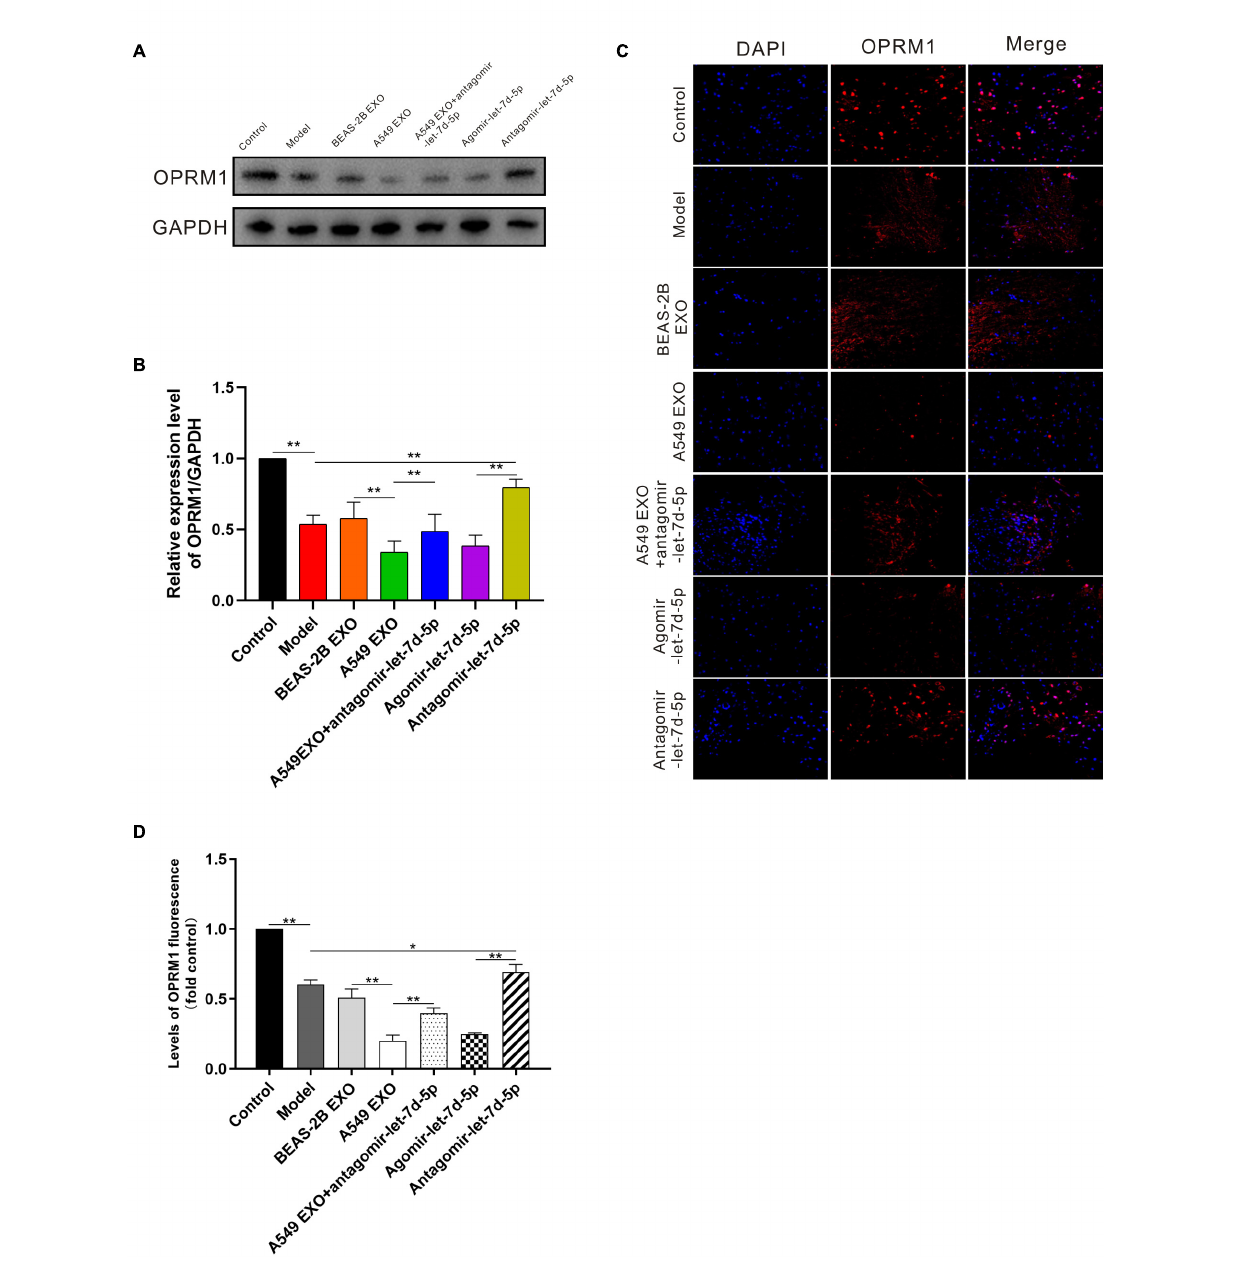
FIGURE 5 | Expression of OPRM1 in the dorsal root ganglion (DRG) of CIBP mice. (A,B) One week after intrathecal injection, western blot analysis showed that in the DRG, OPRM1 protein was significantly reduced in A549 exosome and agomir-let-7d-5p groups. (C,D) Immunofluorescent staining showed that OPRM1 immunoreactivity was significantly reduced in the DRG in A549 exosome and agomir-let-7d-5p groups. Levels of OPRM1 fluorescence in tissues were quantified using Image J software. Scale bar = 50 µ m. * P < 0.05, ** P < 0.01. Datas are presented as mean ± SEM ( n = 6/group). All experiments were performed three